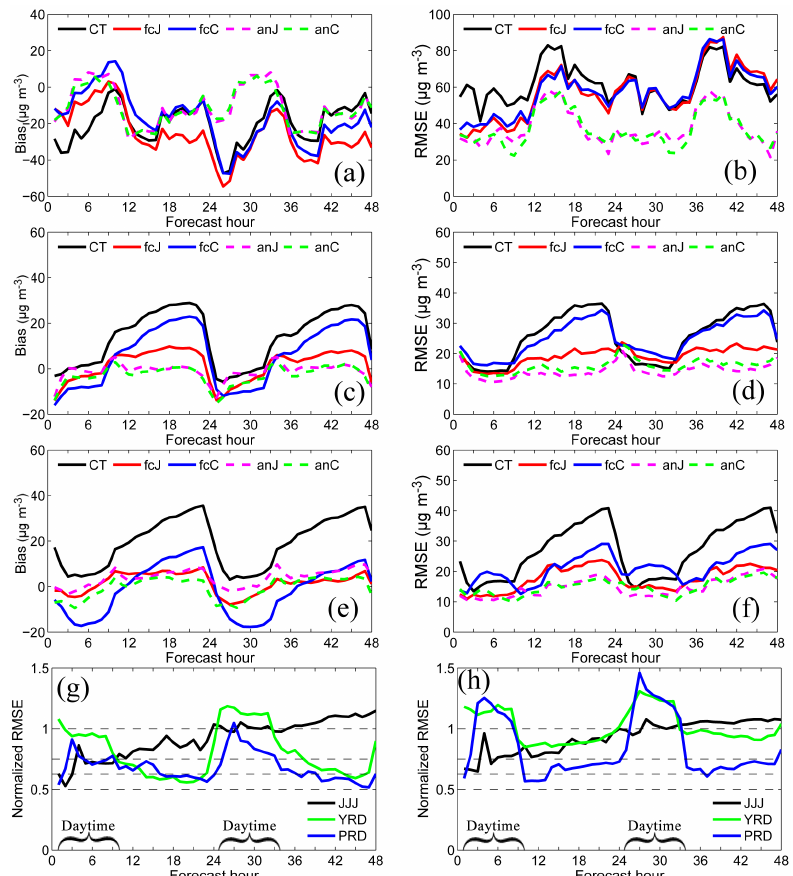
Figure 10. Bias of surface PM 2 . 5 as a function of forecast range calculated against all the independent observations over the three sub-regions shown in Fig. 1: (a) Beijing–Tianjin–Hebei region, (c) Yangtze River delta, (e) Pearl River delta and RMSE over (b) Beijing–Tianjin–Hebei region, (d) Yangtze River delta and (f) Pearl River delta. (g) Normalized RMSE (assimilation divided by control) for expJ and (h) normalized RMSE for expC. The 48h forecasts were performed at each 00:00UTC from 6 to 16 October 2014 and the statistics were computed from 6 to 16